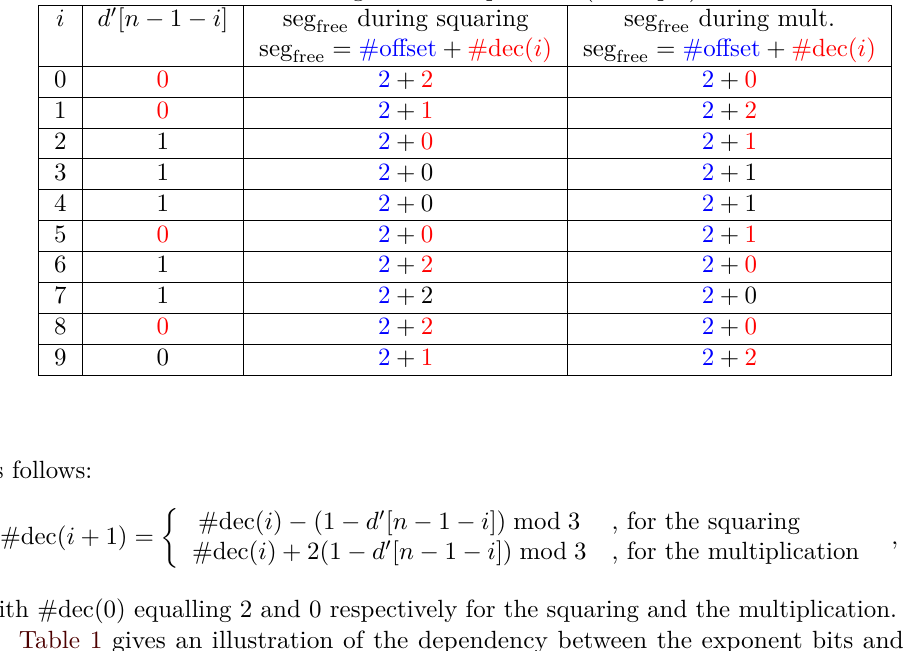
Table 1: Registers Manipulation